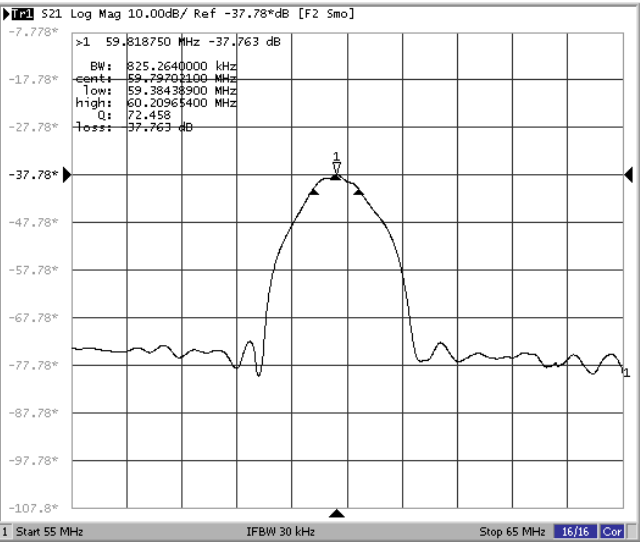
Figure 10. Frequency characteristics of the simply supported beam SAW sensor (no force on the piezoelectric substrate, 25 ° C ).